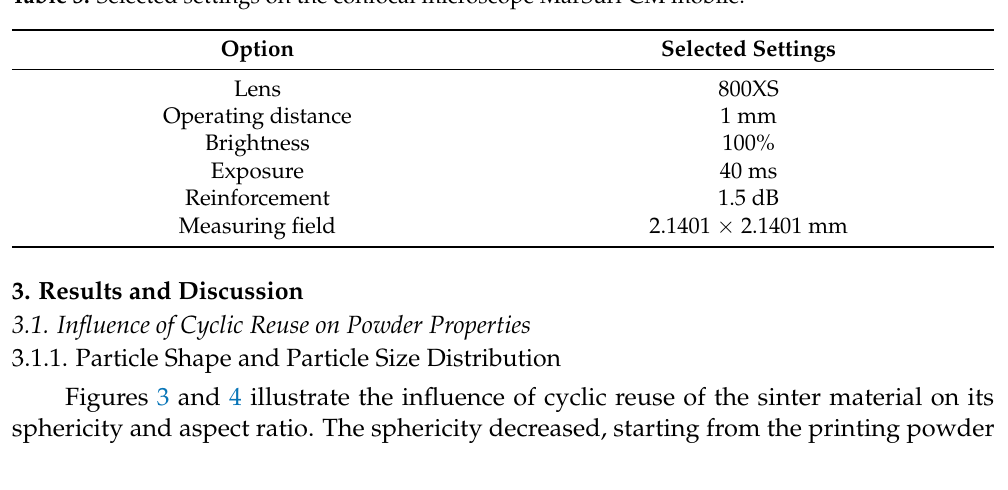
Table 3. Selected settings on the confocal microscope MarSurf CM